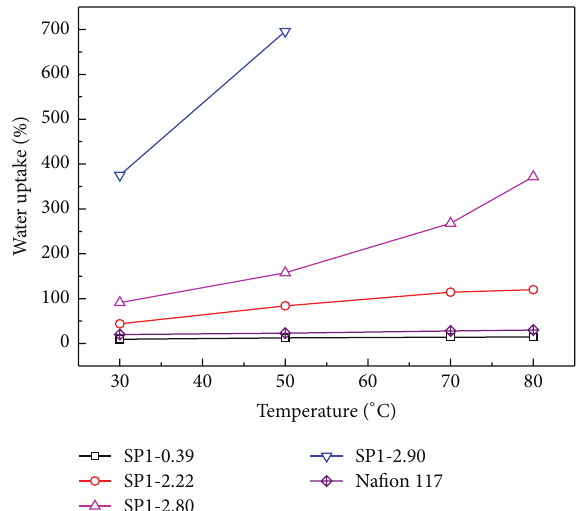
Figure 3: Water uptake as a function of temperature for SP1- 𝑋 membranes.